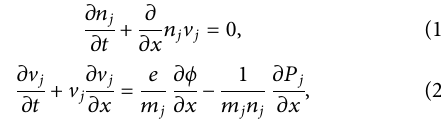
cm − 3 , n h cm − 3 , n b cm − 3 0 = 0.5 0 = 2.5 0 = 1